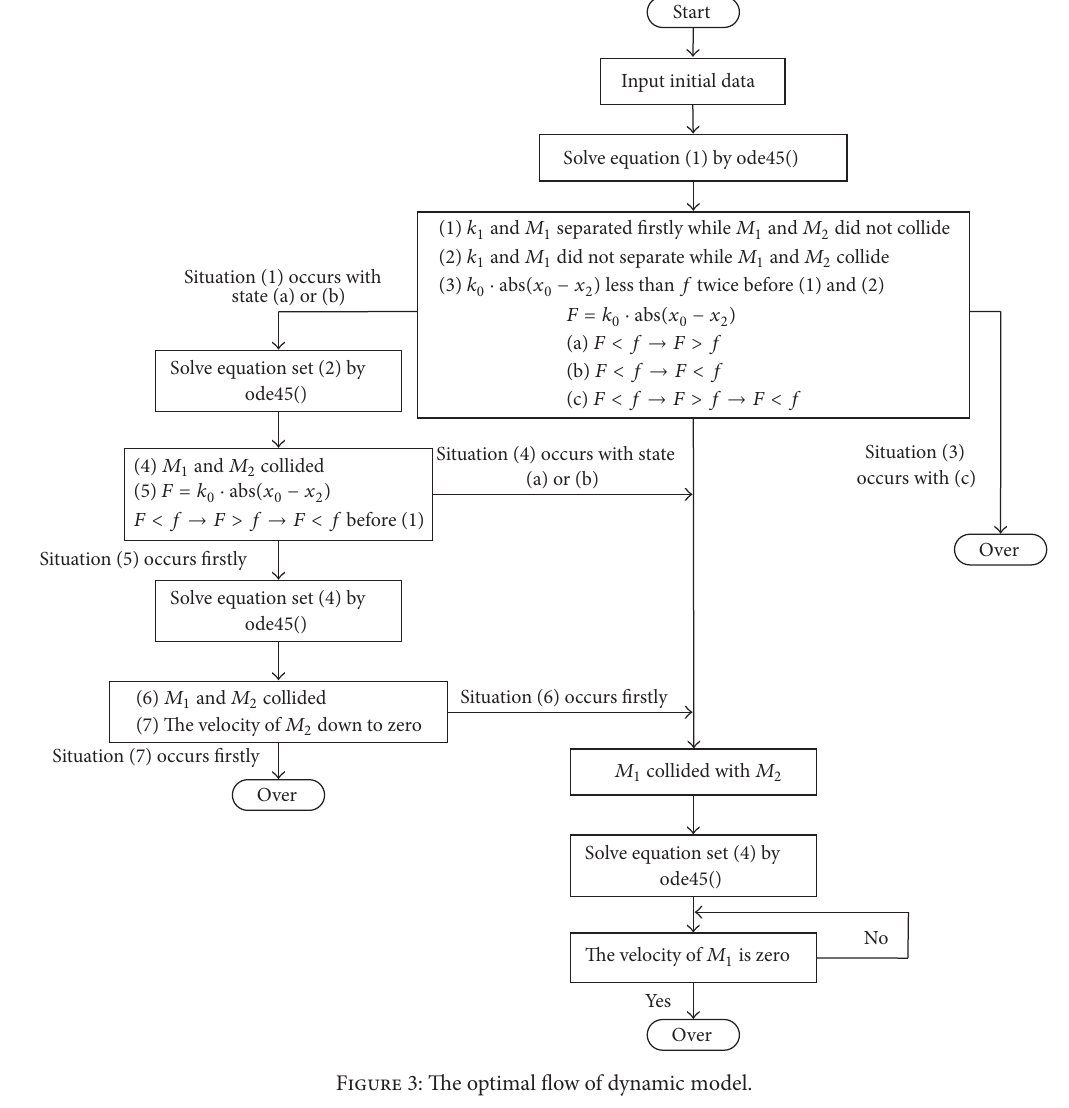
Figure 3: The optimal flow of dynamic model.